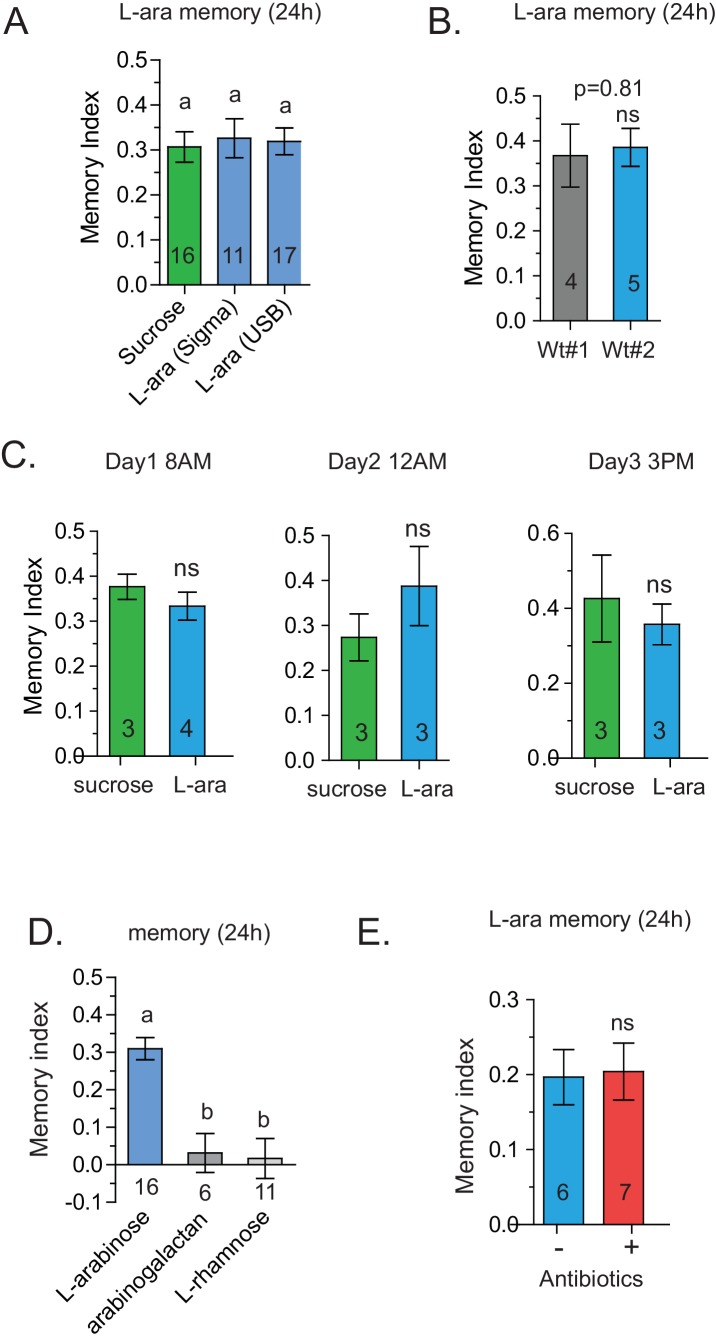
Specificity of L-arabinose memory.(A) L-arabinose from different sources (USB and Sigma) generated equivalent long-term memory, controlling for other contaminating sugars. (B) Canton-S flies obtained from two different labs show similar long-term memory when trained with L-arabinose. (C) Since flies’ feeding behavior can be influenced by the time of day, flies were tested at different times on consecutive days by different experimenters. Under all testing conditions, flies formed long-term memories of L-arabinose. (D) While L-arabinose forms memory, an L-arabinose-galactose polymer does not; neither does another natural L sugar, L-rhamnose, demonstrating the selectivity of L-arabinose memory. (E) Flies fed a cocktail of three broad-spectrum antibiotics (kanamycin, ampicillin, and tetracycline) for the 48 hr before training show memory indistinguishable from untreated control flies. For two samples unpaired two tailed t-tests and for multiple samples one-way ANOVA with Tukey’s multiple comparisons test were performed, and significant differences (p<0.05) are denoted by different letters. Results with error bars are means ± s.e.m. ns, not significant. *≤0.01, **≤0.001 and ***≤0.0001.